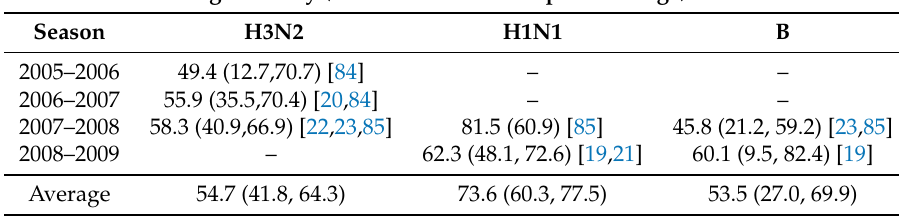
Table A2. Estimated seasonal vaccine efficacy in adults.